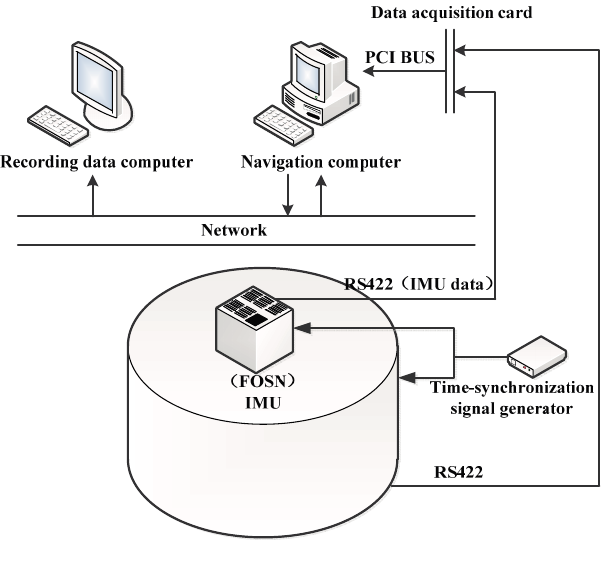
Figure 5 . Experimental